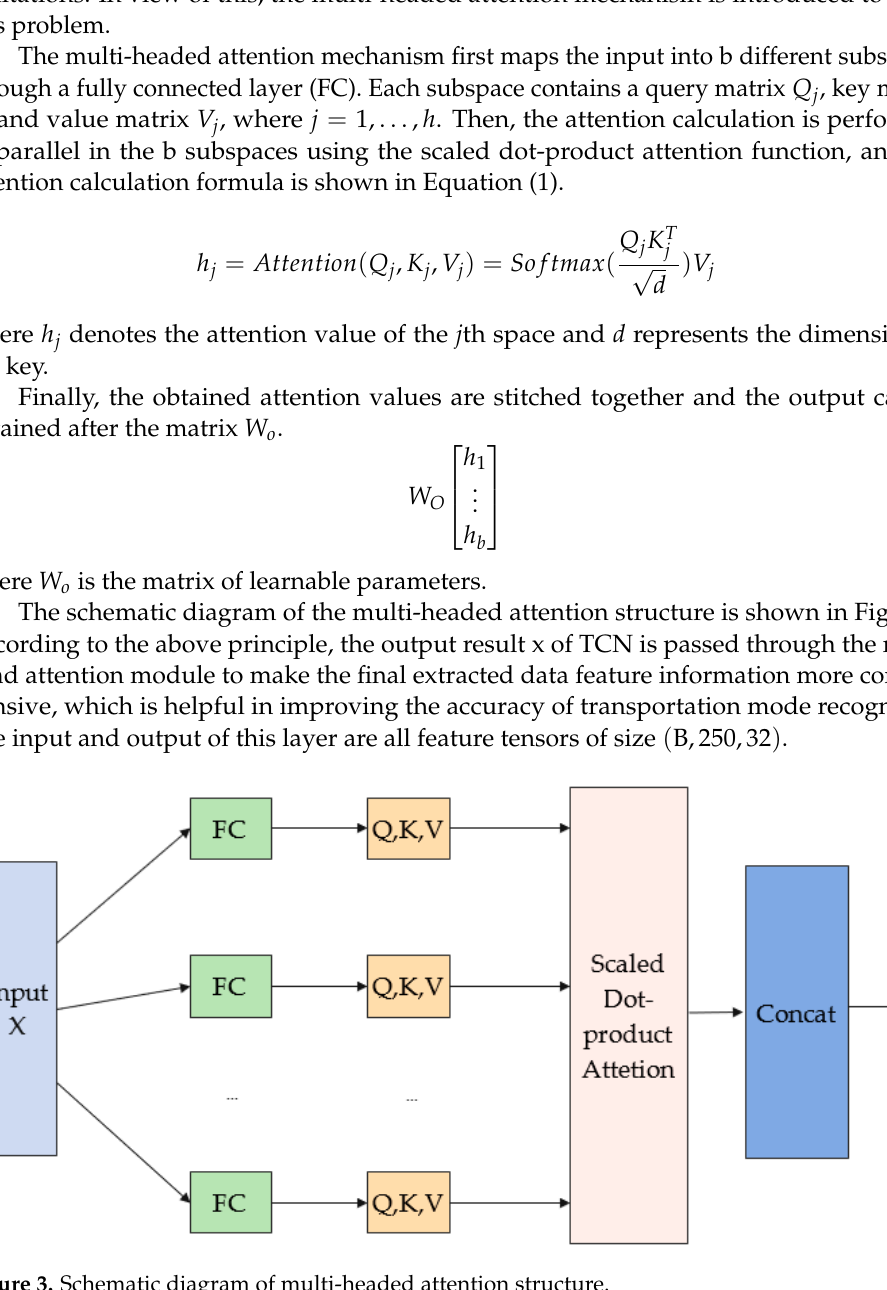
Figure 3. Schematic diagram of multi-headed a tt ention structure.